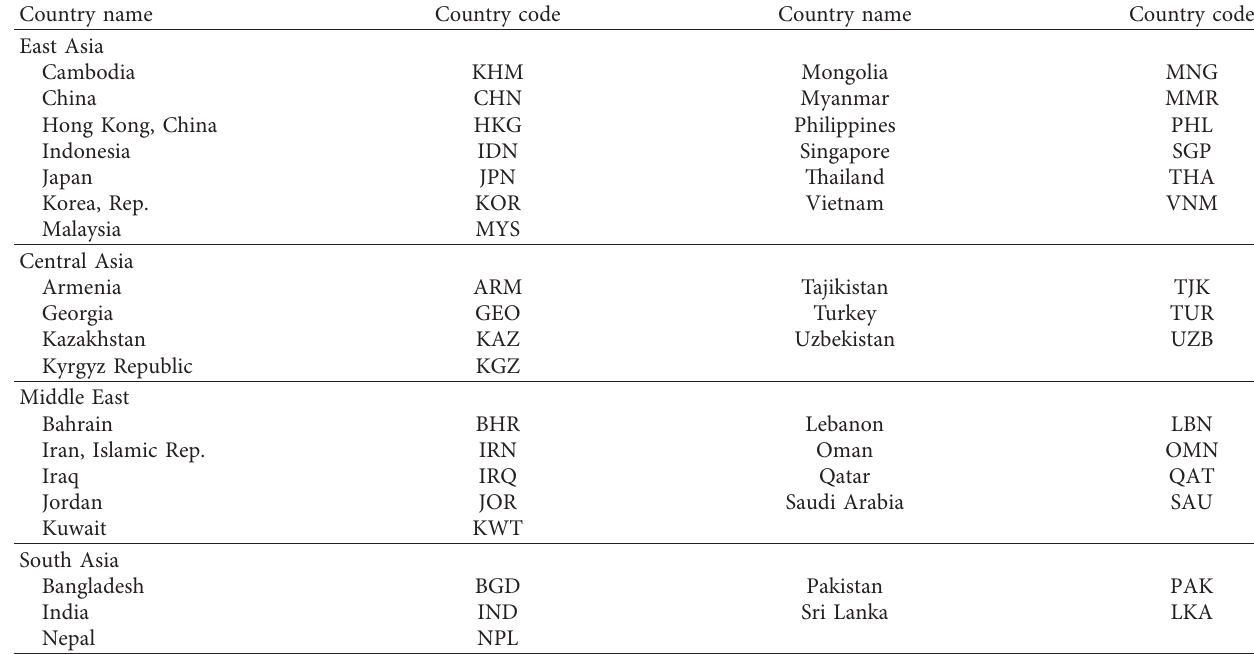
Table 1: Dataset divisions.